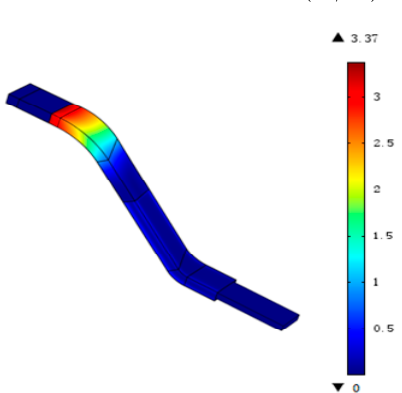
Figure 5. Electric field distribution of the two-segment nonlinear corona protection structure.